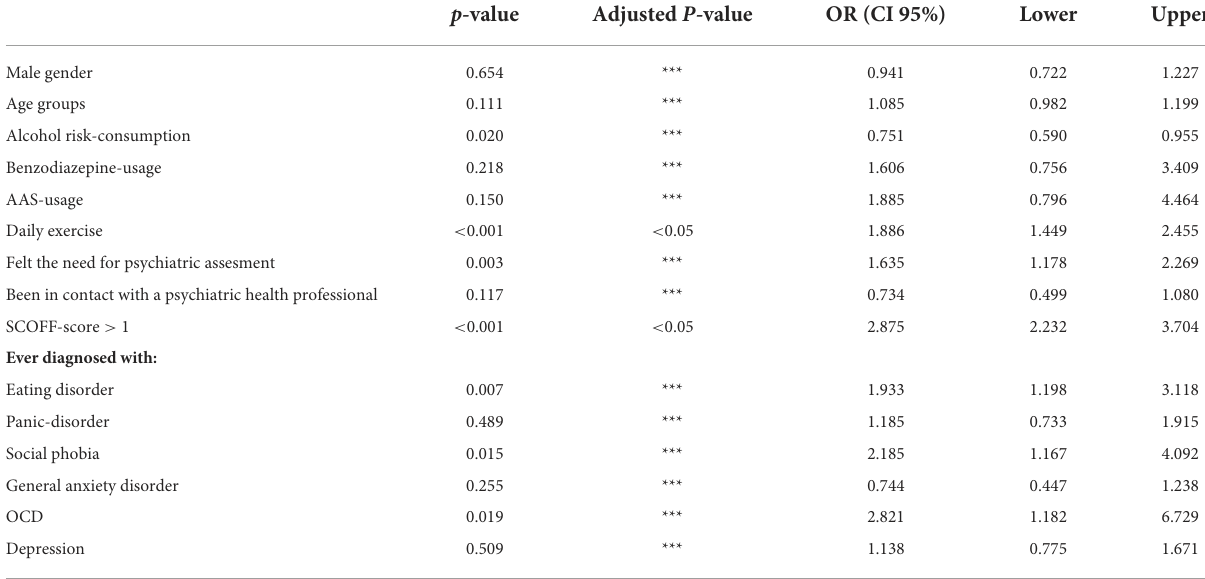
TABLE 2 Binary logistic regression of factors significantly associated with being at-risk of exercise addiction compared to participants not at risk of exercise addiction. p